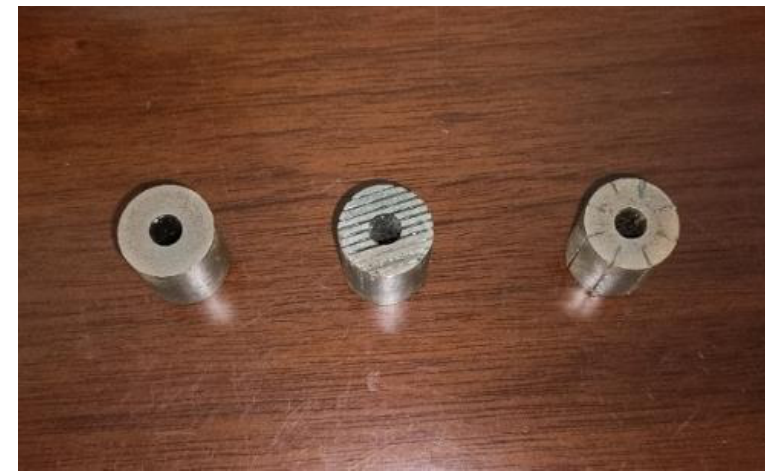
(f) S li ce d a t bo t h e nd s Figure 4. Temperature variation of Terfenol-D rods with time.